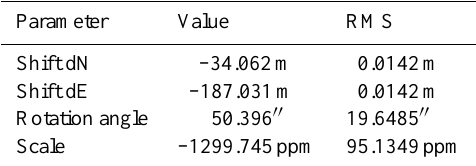
Table 4. Transformation parameters from D¨uzce to Bolu, piers 36 to 47.